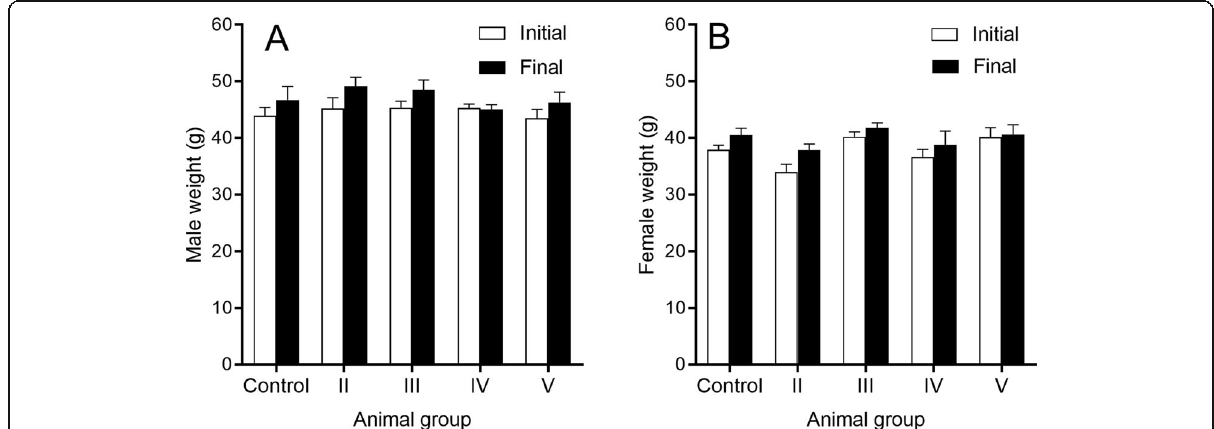
ment. The administration of 3.0 g/kg of PPSB did not result in significant modification in the number of